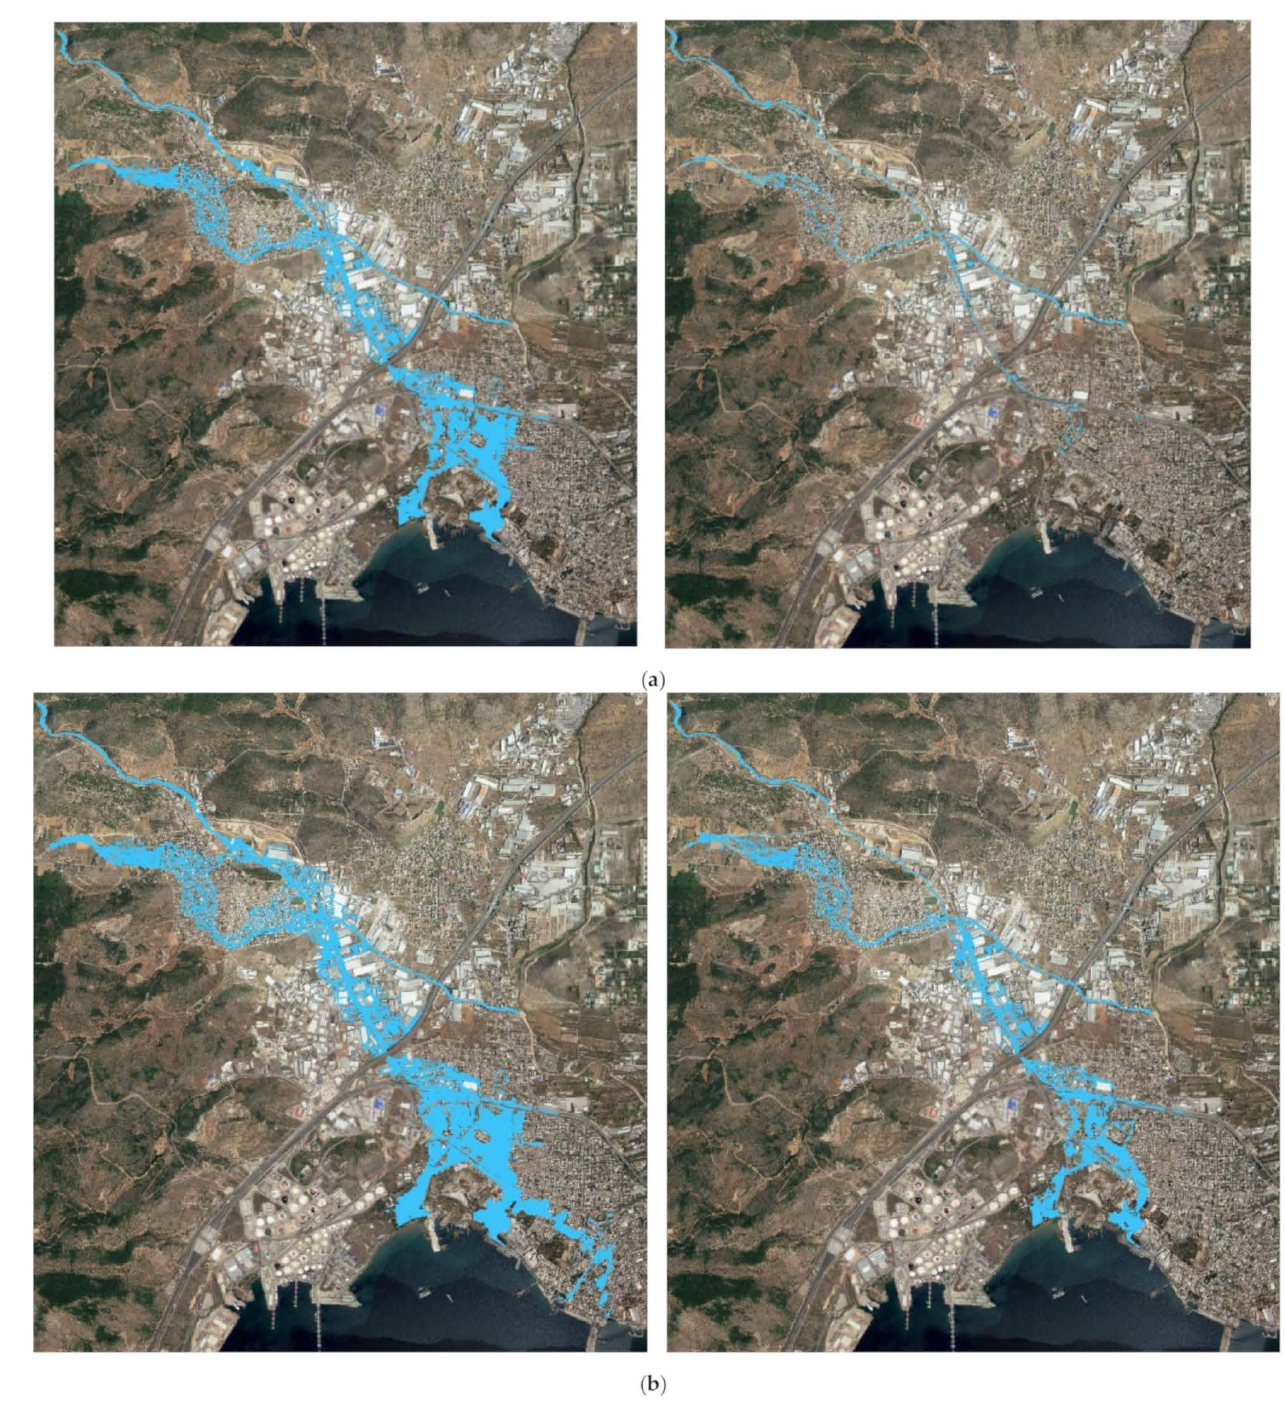
Figure 4. Inundation area for 4 indicative scenarios: ( a ) Scenarios S20-06 ( left ) and W20-06 ( right ) for T = 20 y and t = 6 h. ( b ) Scenarios S200-18 ( left ) and W200-18 ( right ) for T = 200 y and t = 18